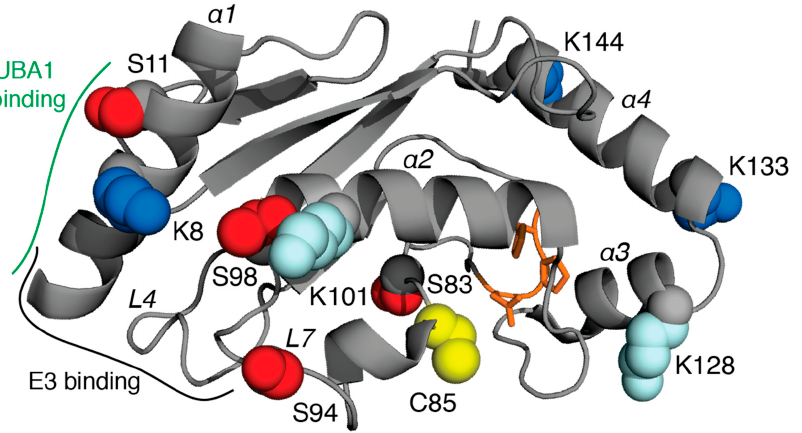
Figure 3. Acetylation, phosphorylation, and ubiquitination sites in E2 conjugating enzymes. Residues observed to be acetylated or ubiquitinated (blue), phosphorylated (red), or only ubiquitinated (pale blue) in the UBE2D family (UBE2D1-UBE2D4) are indicated using the structure of UBE2D3 (PDB 5EGG) as a template [118]. Not all sites are found in all family members. The catalytic cysteine (C85) is shown in yellow and the HPN motif is shown in orange sticks. Helices and discussed loops are labelled in italics. Regions along helix α 1 and the L4, L7 loops where UBA1 and E3 enzymes interact are indicated.